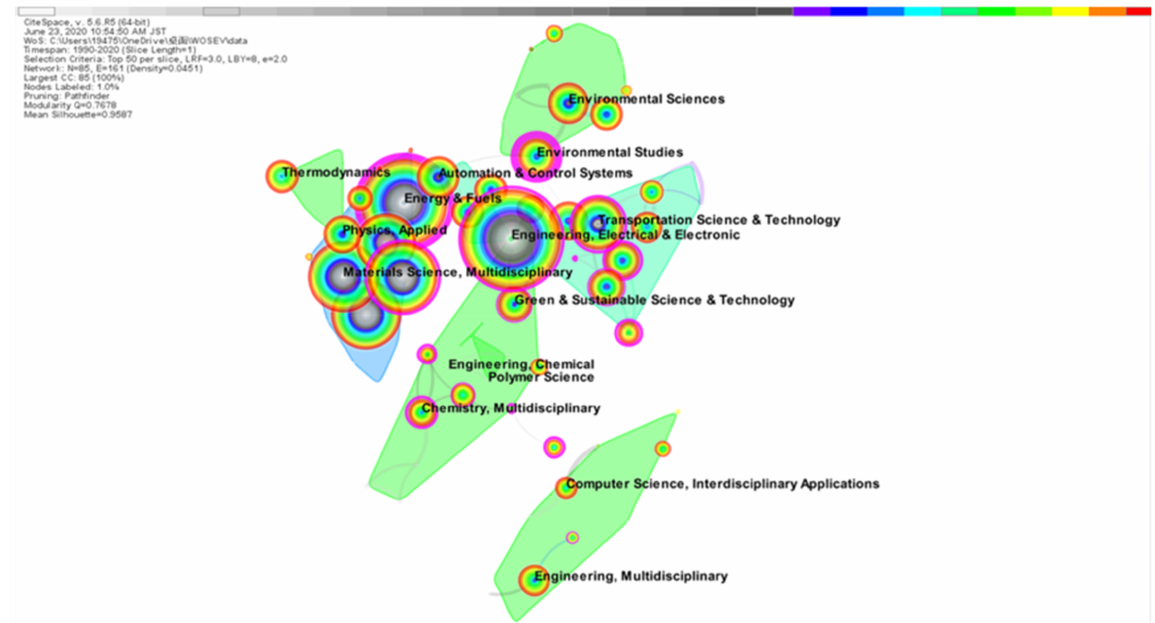
Figure 6. Main research categories of